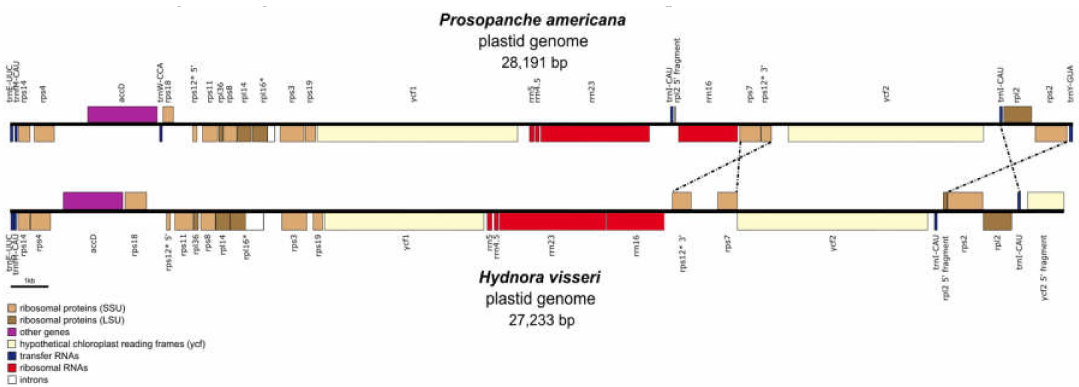
Figure 5. High structural similarity between the plastomes of Hydnoraceae. Linear plastid genome comparison of Prosopanche americana and Hydnora visseri (NC_029358). Genes are color coded; the dotted lines highlight inversions between the two genomes compared, genes containing introns are marked with